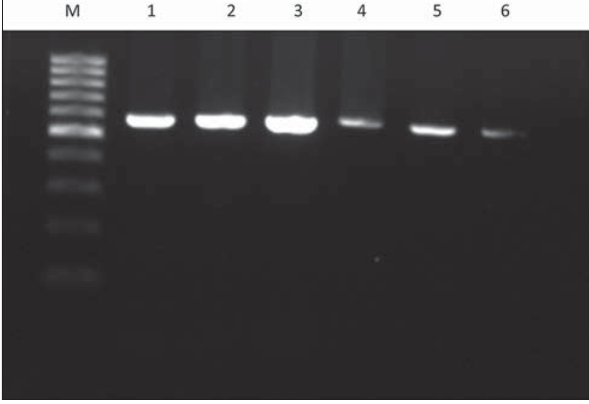
Figure-1: 1% agarose gel electrophoresis showing 564 bp size band from positive samples. Lane M: 100 bp plus ladder. Lane 1-6: Positive samples.